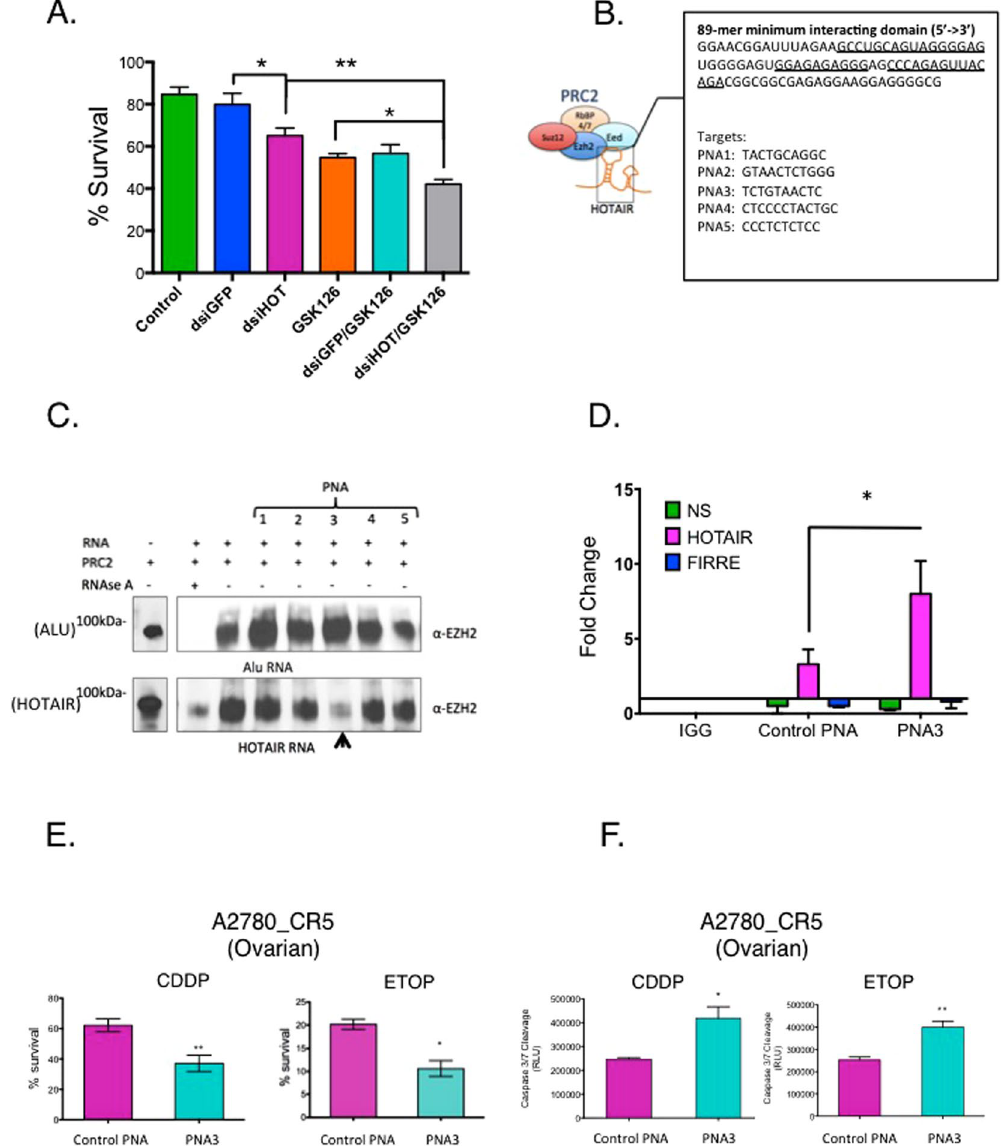
Figure 1. Inhibition of HOTAIR and EZH2. (A) A2780_CR5 cells were treated with EZH2 inhibitor (GSK126 5 μ M) or transfected with either dsiGFP or dsiHOTAIR (50 nM) for 24 hrs trypsinized and replated into 96 well plates in triplicate for 72 hrs. Cell survival was determined with MTT assay. (B) 89-mer minimum-interacting region of HOTAIR and the sequence of the PNAs used in this study. (C) In vitro transcribed and biotinylated HOTAIR or ALU RNA (1 μ M) were incubated with PNA1-5 (1 μ M) for 1 hr at 25 °C followed by pull-down with streptavidin coated protein A/G plus agarose beads. 50 ng of recombinant EZH2 was added and binding was observed in a polyacrylamide gel. (D) PNA3 or control PNA were biotinylated and incubated with MCF-7 cell lysate for 1 hr followed by a modified ChIRP assay. Graph represents the fold change of HOTAIR as measured by qRT-PCR compared to control non-specific gene and lncRNA FIRRE. (E) A2780_CR5 cells were treated with either PNA3 or control PNA (1 μ M) for 24 hrs, and re-plated for clonogenic survival and treated with either CDDP (30 μ M) or etoposide (5 μ M) for 3 hrs and 24 hrs post-treatment (F) Caspase 3/7 cleavage assay was performed. All western blot data were cropped and acquired under same experimental conditions. Asterisks indicate P < 0.05 ( * ) or P < 0.01 ( **